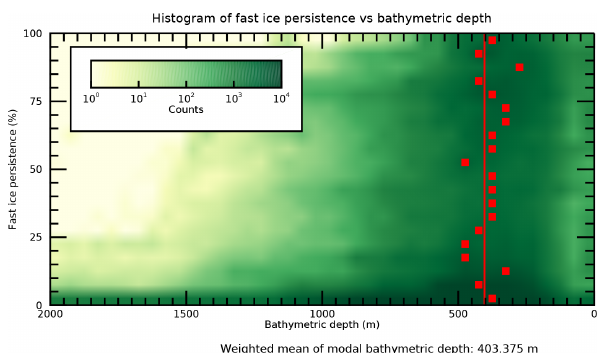
Figure 6. Two-dimensional histogram of circumpolar fast-ice per- sistence ( y axis) versus bathymetric depth ( x axis, taken from the International Bathymetric Chart of the Southern Ocean; Arndt et al., 2013). For each fast-ice persistence bin (5% wide bins), the most frequent (modal) depth value is highlighted with a red square. The persistence-weighted mean of these modal values is indicated with the red vertical line, here corresponding to a bathymetric depth of ∼